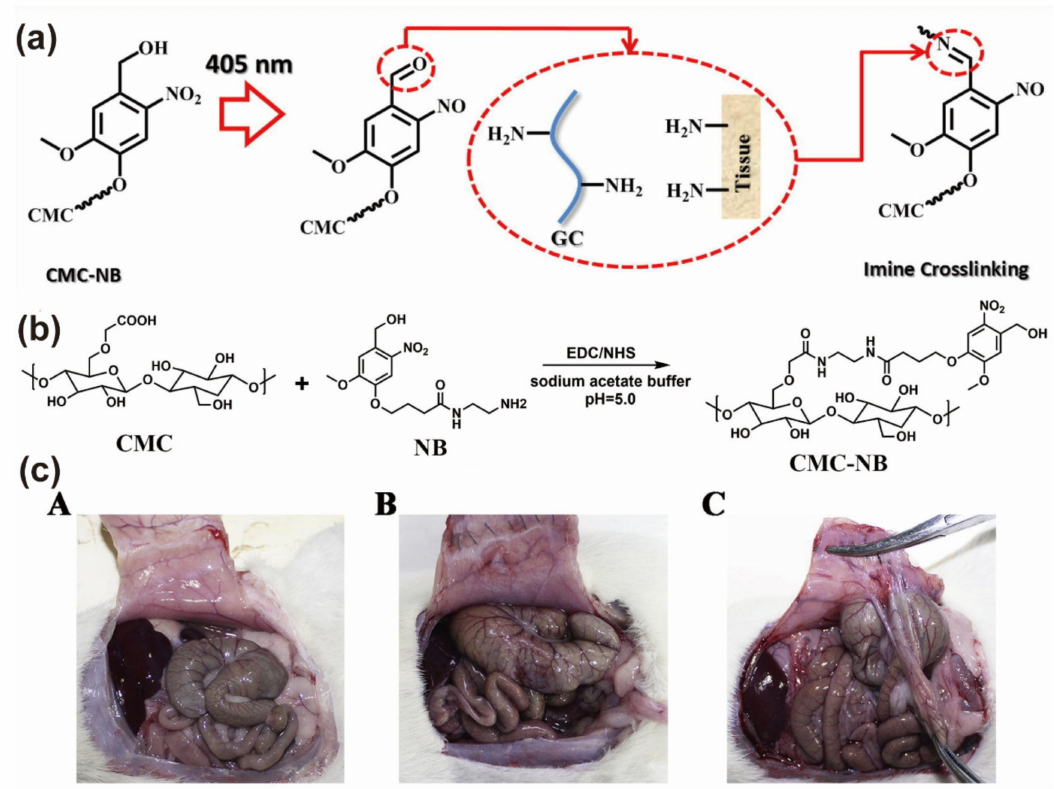
Figure 6. ( a ) Schematic illustration of CNG hydrogel for postoperative anti-adhesion in 405 nm. ( b ) The diagram of synthetic route and structure of CMC-NB hydrogel. ( c ) Anti-adhesion efficacy assessment by the abdominal wall-cecum defect model of SD rats. Gross observation of the abdominal wall-cecum sites in SD rats treated by CNG1 hydrogel (A), HBC hydrogel (B), or saline rinsing (C) on the 14th day after surgery. Reprinted with permission from Ref. [24]. Copyright 2017 Acta Materialia